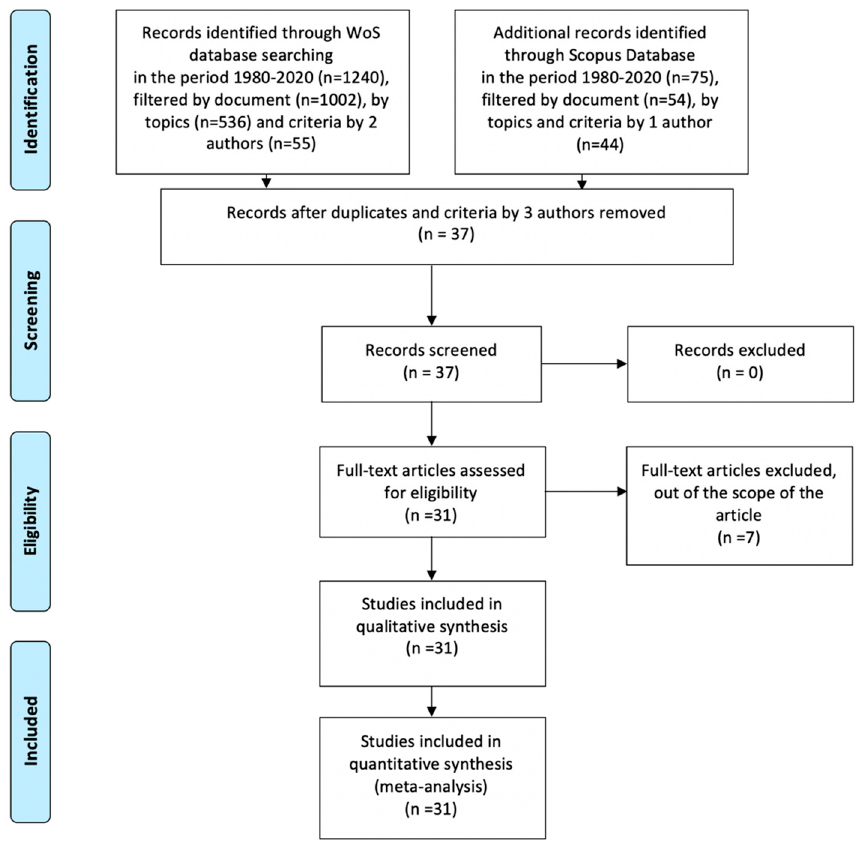
Figure 4. Flow diagram of the study selection process PRISMA (Preferred Reporting Items for Systematic Reviews and Meta-Analyses). Sensors 2021 , 21 , x FOR PEER REVIEW